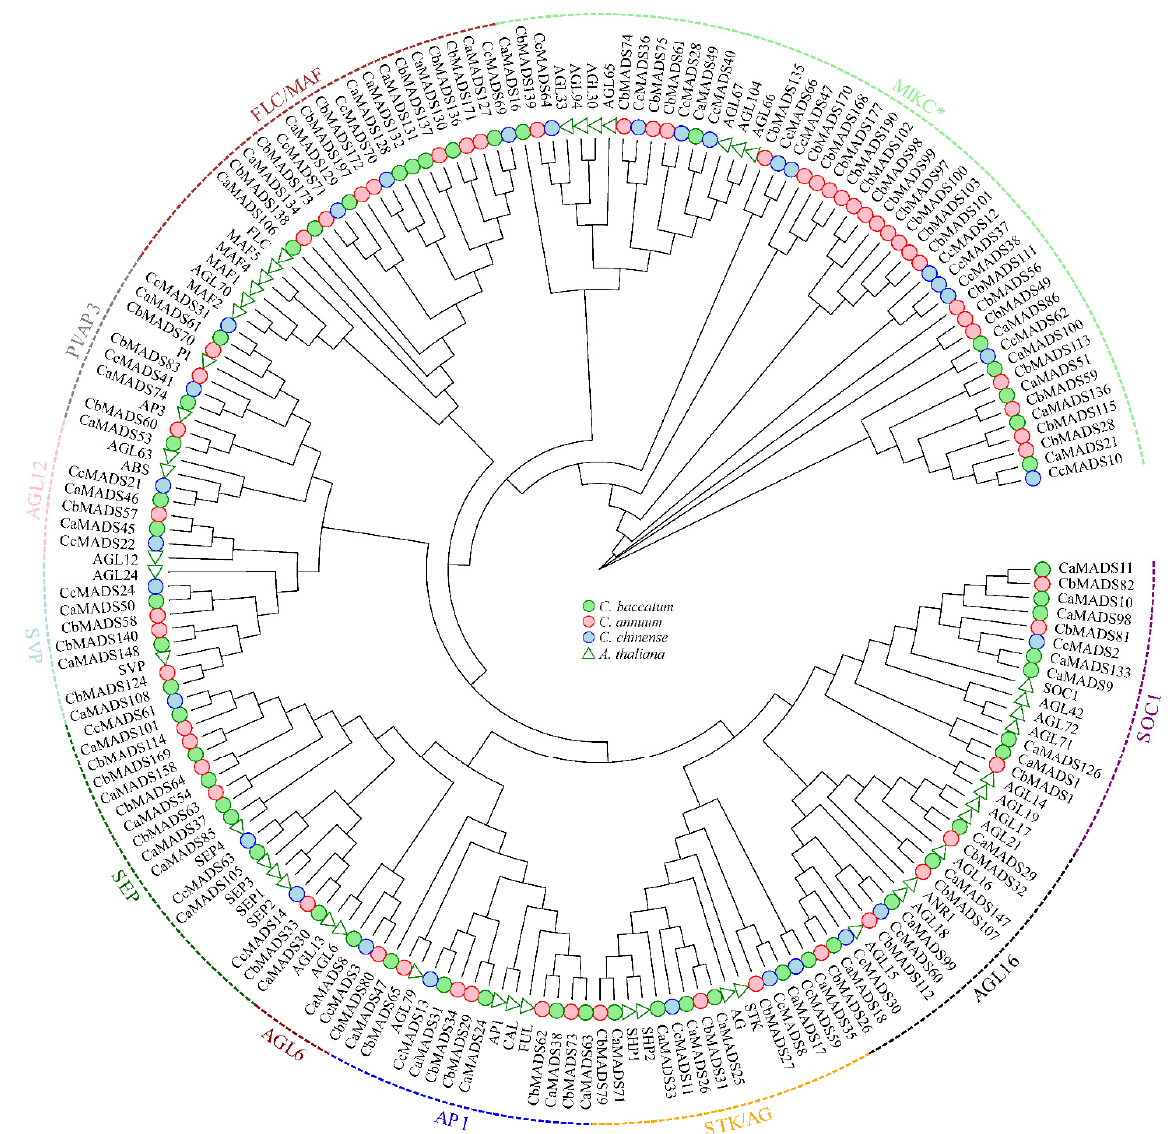
Figure 1. Phylogenetic tree of type II MADS-box genes in Arabidopsis thaliana , Capsicum annuum , C . baccatum , and C . chinense .